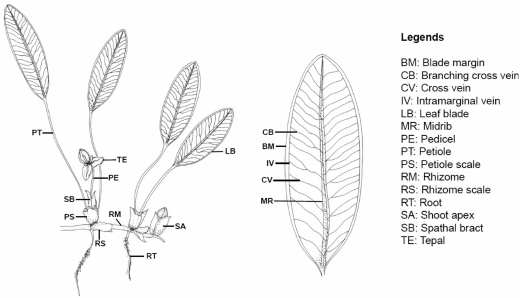
Figure 2. Botanical drawings of Halophila characteristics described in the keys and species